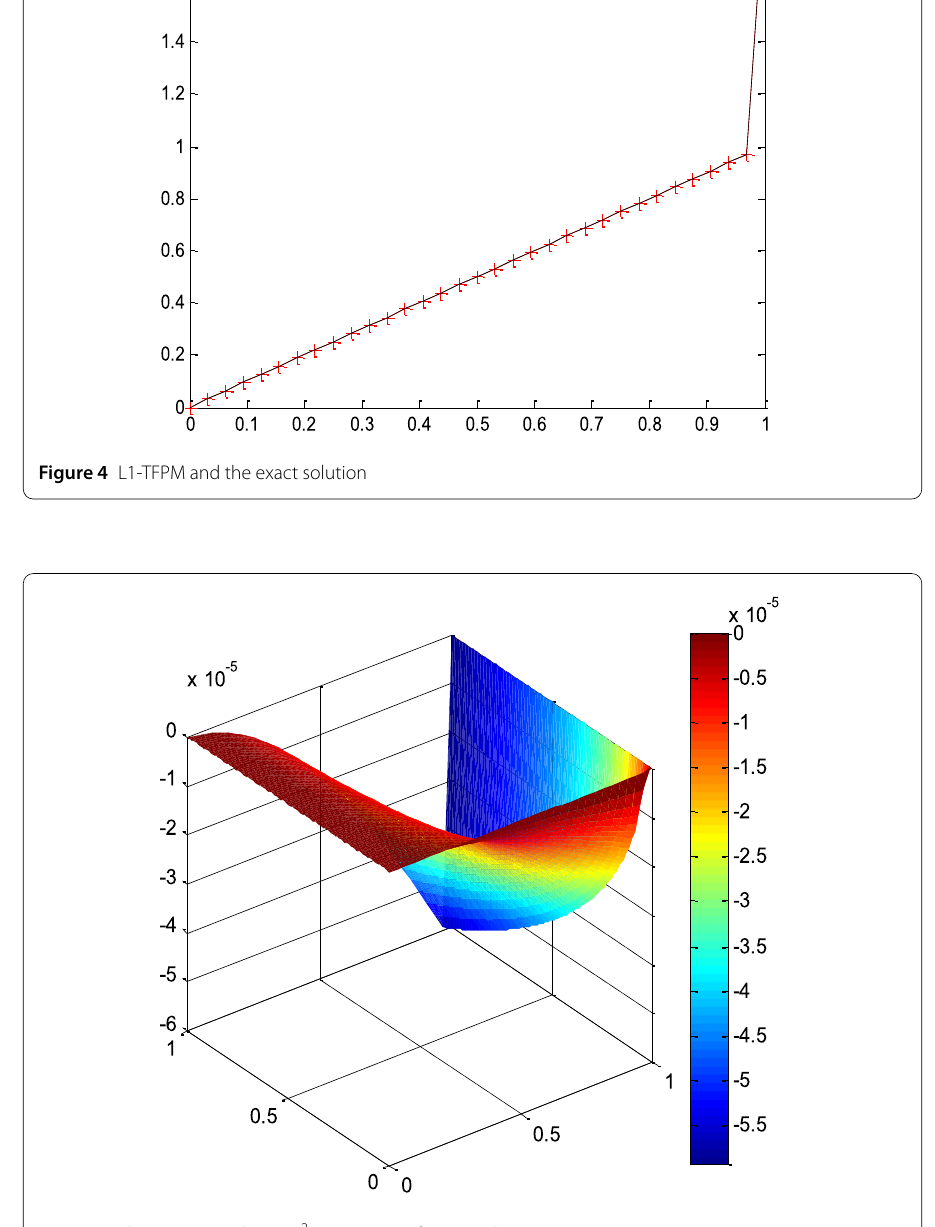
Figure 5 The GL-TFPM scheme L 2 -norm error of γ = 0.2, h =